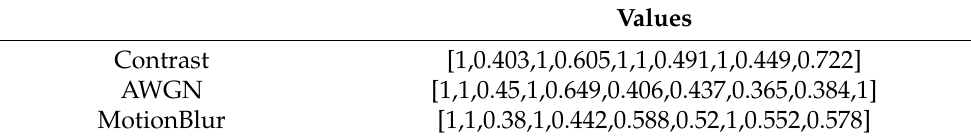
Table 2. Values for the three noisy MNIST versions.